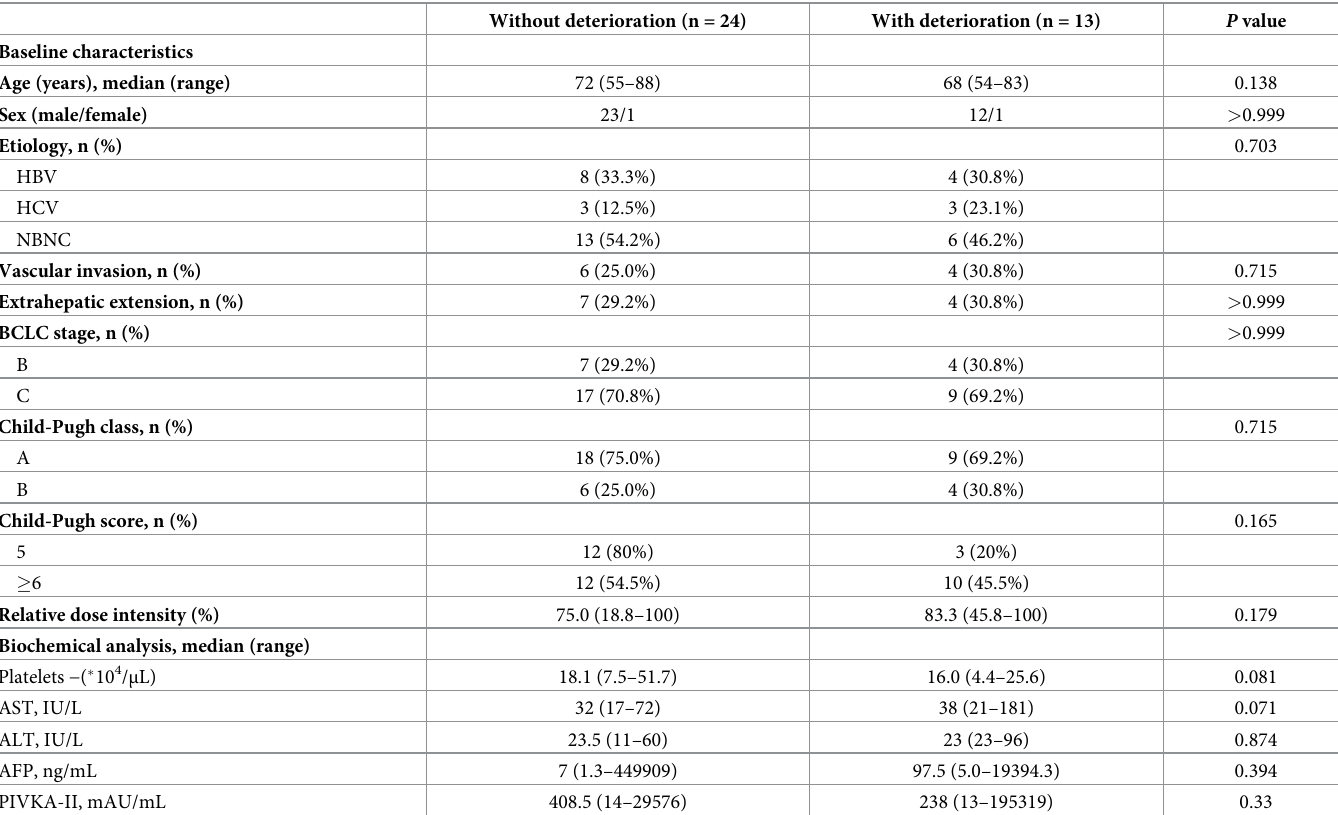
Comparison of patient characteristics between patients with and without deterioration of Child-Pugh score at 8 weeks after lenvatinib initiation As shown in Table 2, 24 (65%) and 13 (35%) patients exhibited a maintained/improved and deterioration of Child-Pugh score, respectively, at 8 weeks post lenvatinib initiation. The most common deterioration factor in the Child-Pugh score was the serum albumin level (S2 Fig). We compared these two patient groups. As shown in Table 3, the etiology of liver disease, sex, age, BCLC stage, Child-Pugh class, and tumor markers were similar between these patient Without deterioration (n = 24) With deterioration (n = 13) P